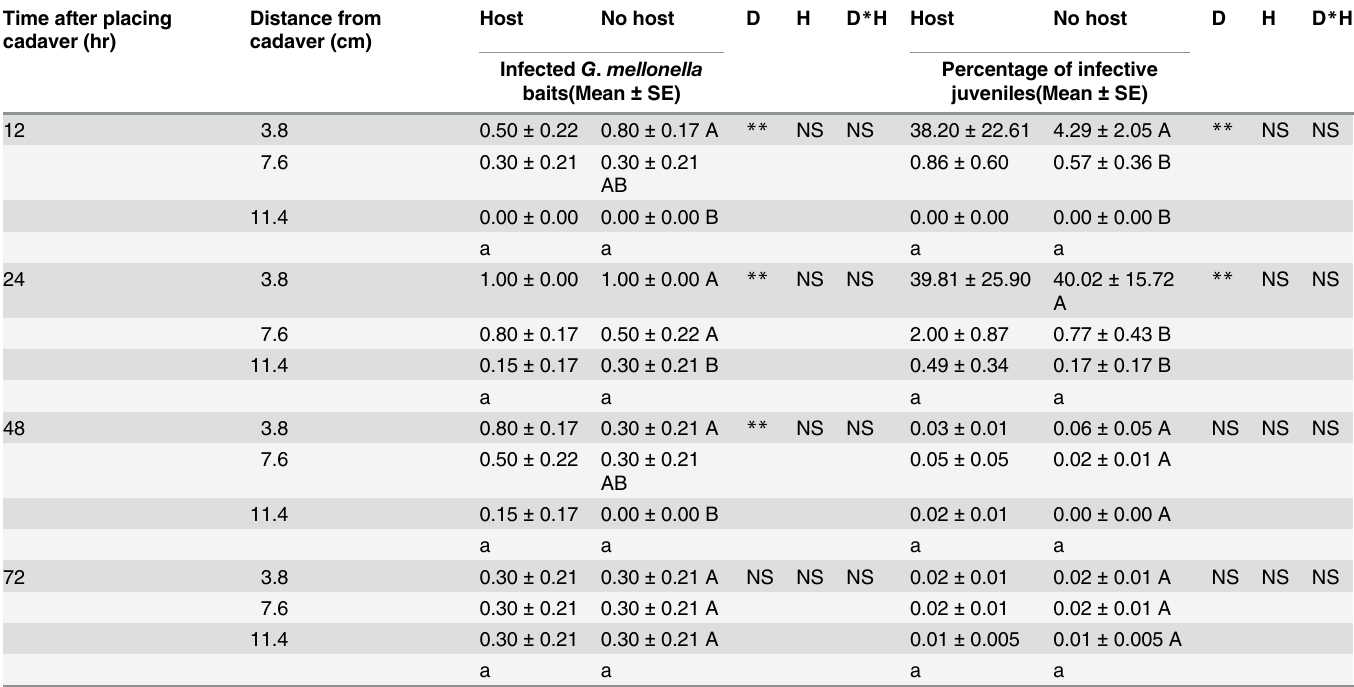
Mean ( ± SE) number of infected Galleria mellonella baits from the collected soil core samples and mean ( ± SE) percentage of infective juveniles (IJs) of Steinernema carpocapsae dispersed to a 2 cm wide arc at distances, 3.8, 7.6 and 11.4 cm over a period of 12 to 72 hr in the presence of a live non- mobile host, G . mellonella contained in a wire mesh cage buried in one of the quadrants in the microcosms containing autoclaved fi eld soil with vegetation in comparison with the opposite quadrant of the same microcosm containing no host. Double asterisk ( ** ) indicates signi fi cant difference between distances (D), presence or absence of the host (H) and interaction between the two (D * H) at a time point at P (cid:1) 0.05. Capital and small letters indicate Tukey ’ s comparison for means separation between distances averaged over presence or absence of the host, and presence and absence of host averaged over distances, respectively at a time point. NS = P >